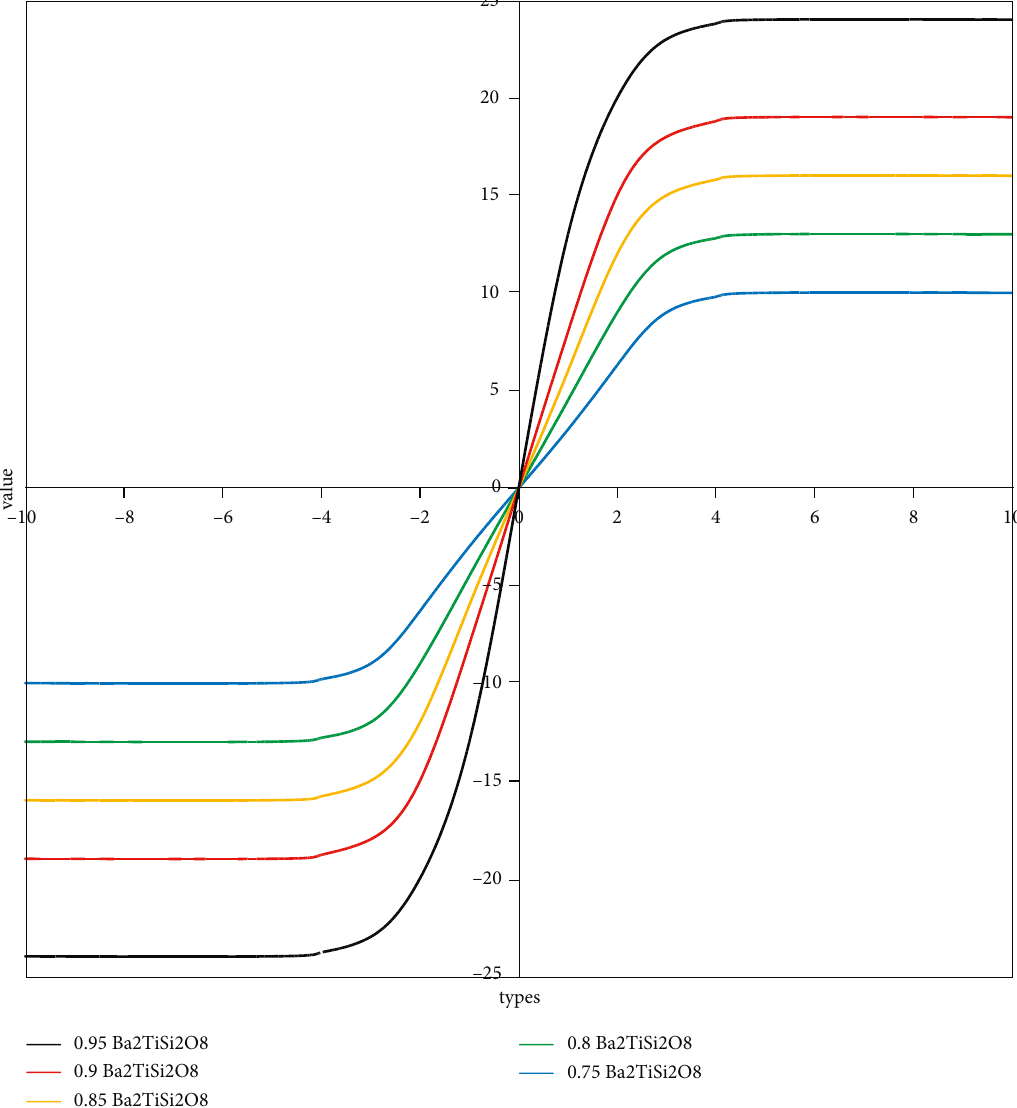
2 TiSi 2 O 8 flexible